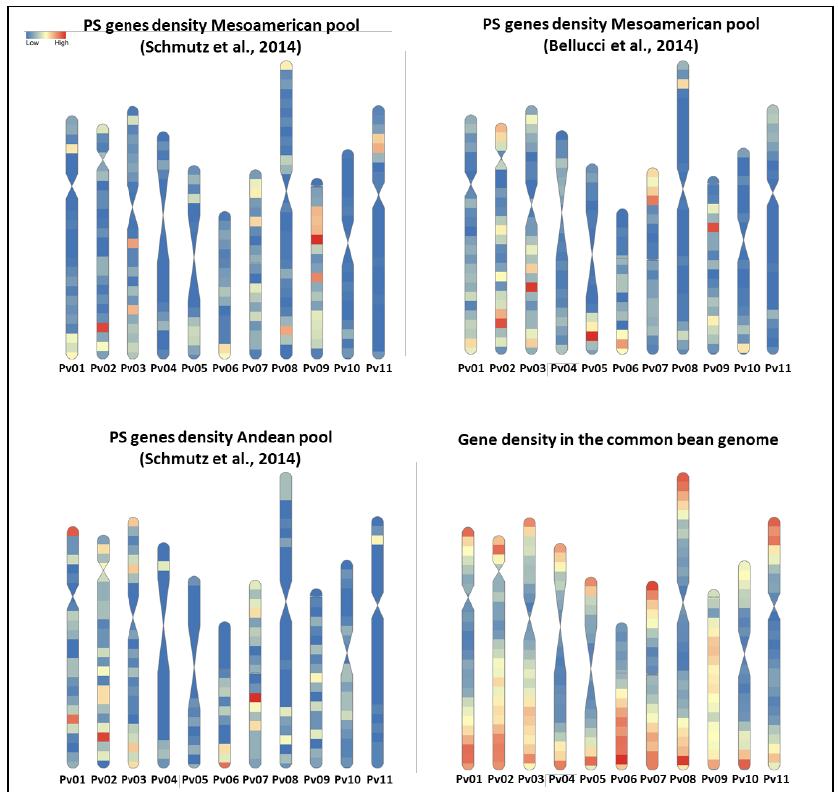
Figure 3. Genome-wide distribution of putatively under selection (PS) genes. Top left : distribution of PS genes in the Mesoamerica gene pool, according to Schmutz et al. [29]. Top right : distribution of PS genes in the Mesoamerica gene pool, according to Bellucci et al. [23]. Bottom left : distribution of PS genes in the Andean gene pool, according to Schmutz et al. [29]. Bottom right : gene density across the entire genome. Gene density is highlighted according to the color intensity in the legend at a 2-Mb window scale.